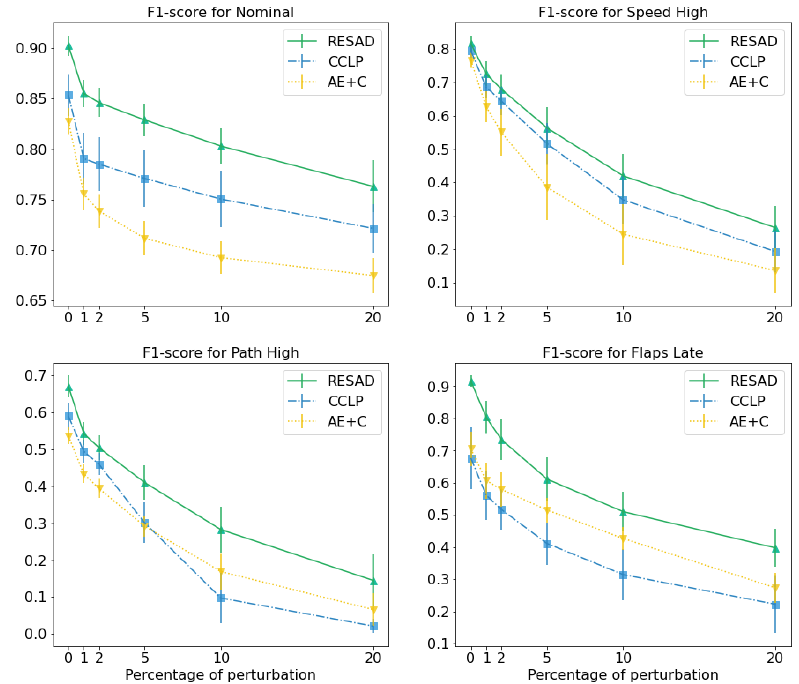
Figure A7. Comparison of our proposed model, CCLP, and AE+C for per-class F1-score with respect to increasing percentages of adversarial